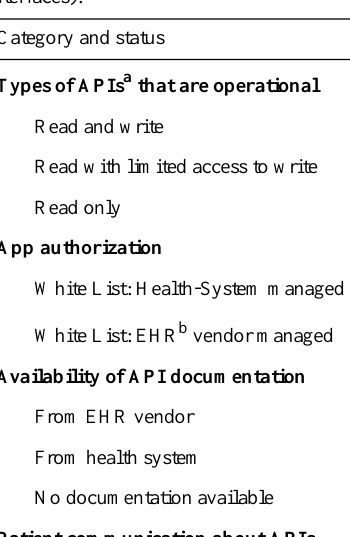
Table 3. Current status of patient-facing application programming interfaces (among eight organizations with operational application programming